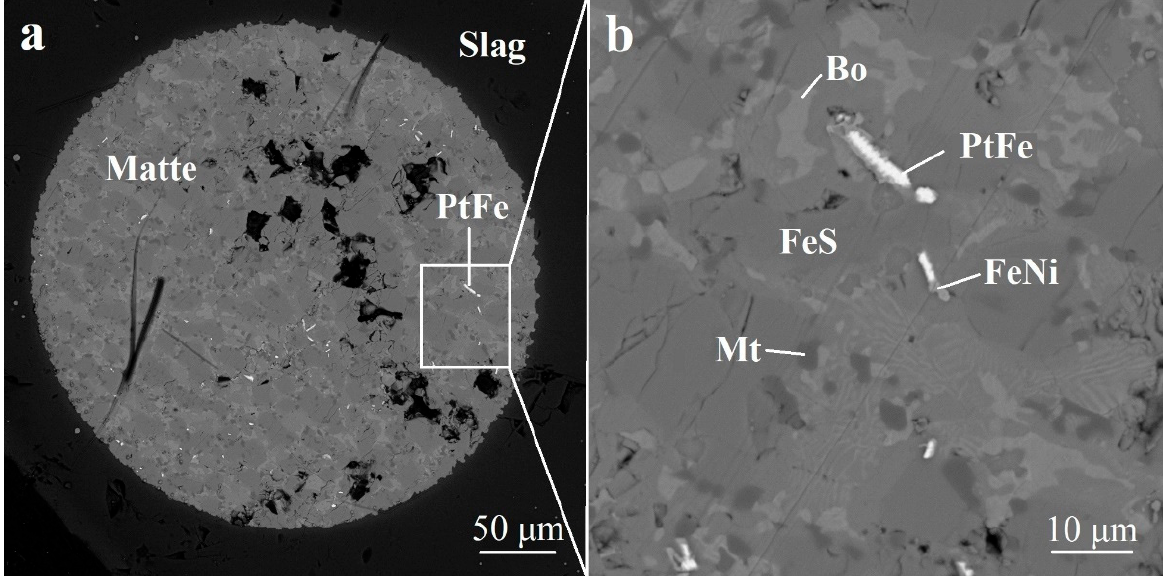
Figure 4. Needle-like PtFe particles in a matte drop that is in the slag: ( a ) general view of a matte drop in the slag, ( b ) enlarged fragment of a drop with platinum-containing particles. The slag obtained after melting copper–nickel sulfide ore at a temperature of 1300 °C.